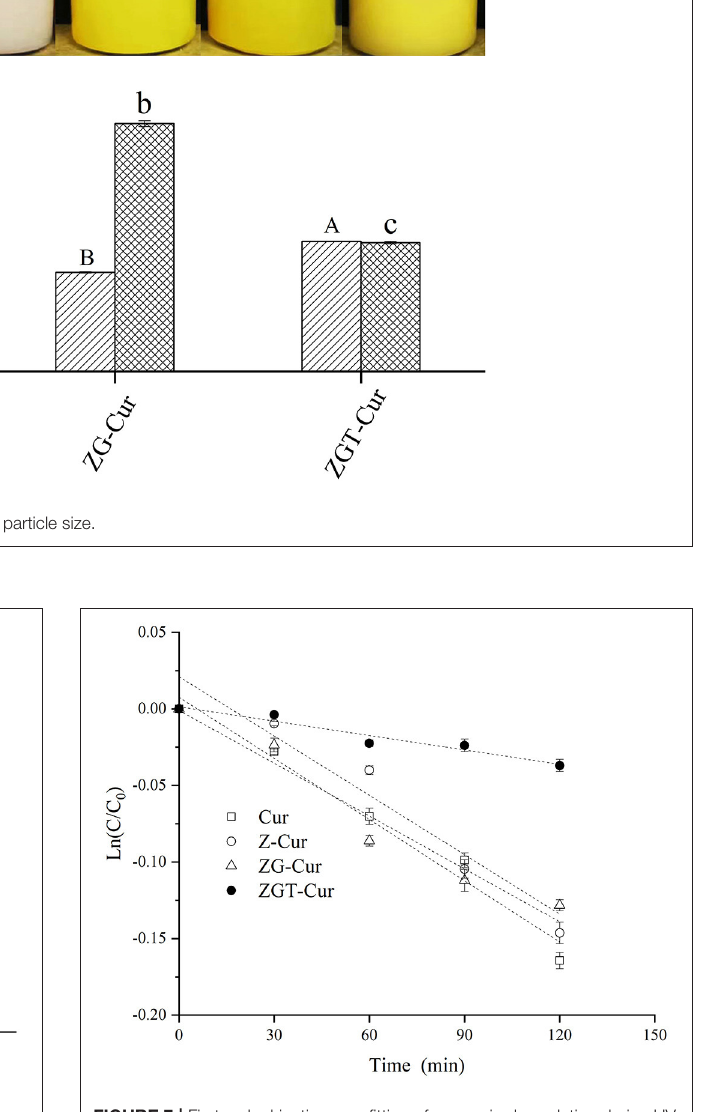
FIGURE 6 | Effect of different temperatures (25, 45, 65, and 85 ◦ C) on retention rates of Cur in composite particles.